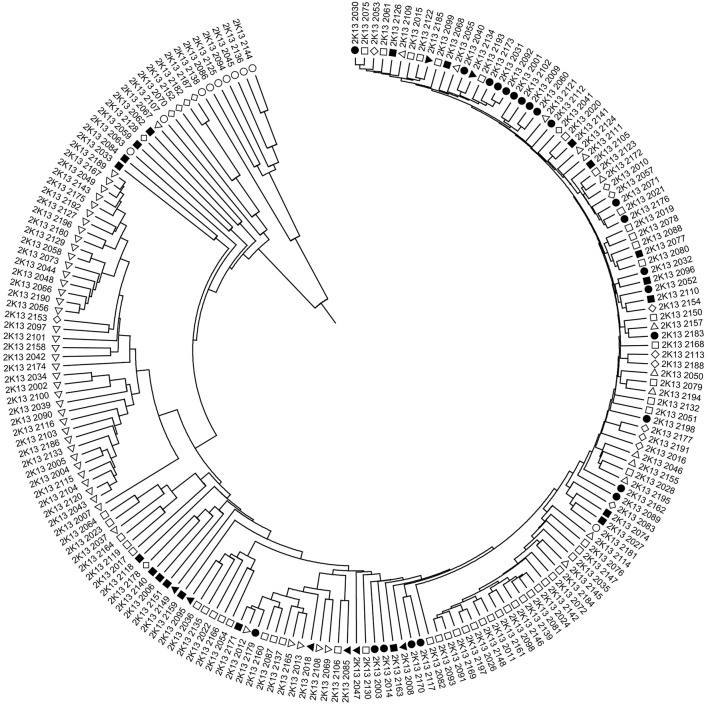
UPGMA dendrogram of 192 tomato accessions based on 547 InDel marker data. Symbols represent accessions from different species or market class of tomato: ○ Solanum pimpinellifolium, ◊ S. lycopersicum var. cerasiforme or cherry tomato, ■ Latin American Cultivar, □ Fresh-market, Δ Processing, • Vintage, ▼ Unknown type. The accession of each plot number can be found in Table S1.